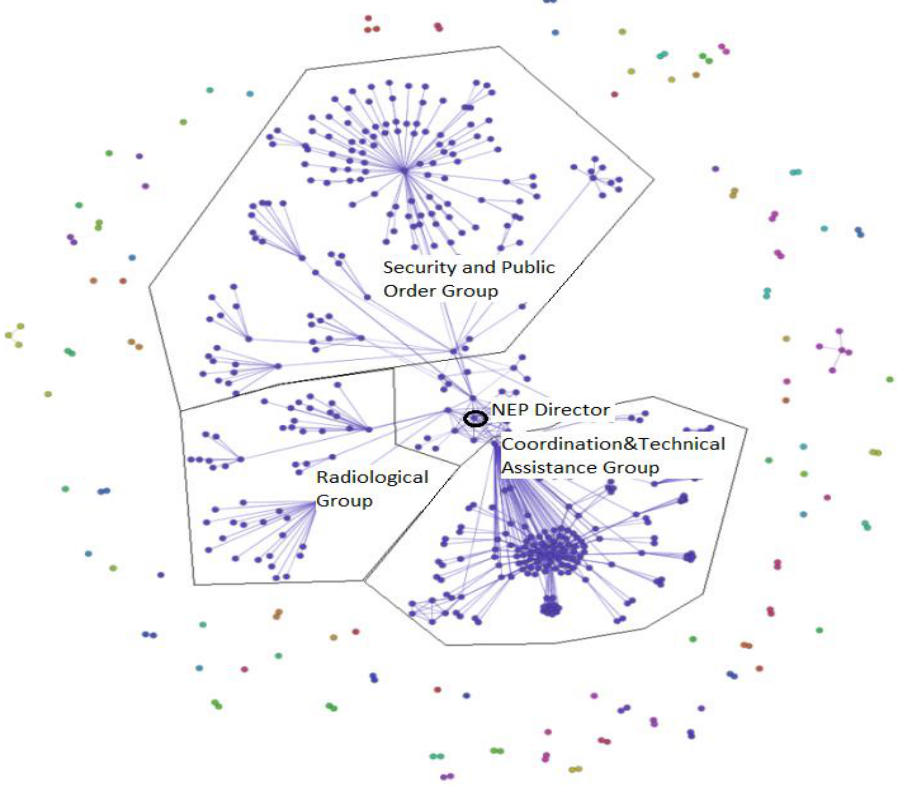
Figure 4. Collapse in the phone communication channel. Scenario 1. Case